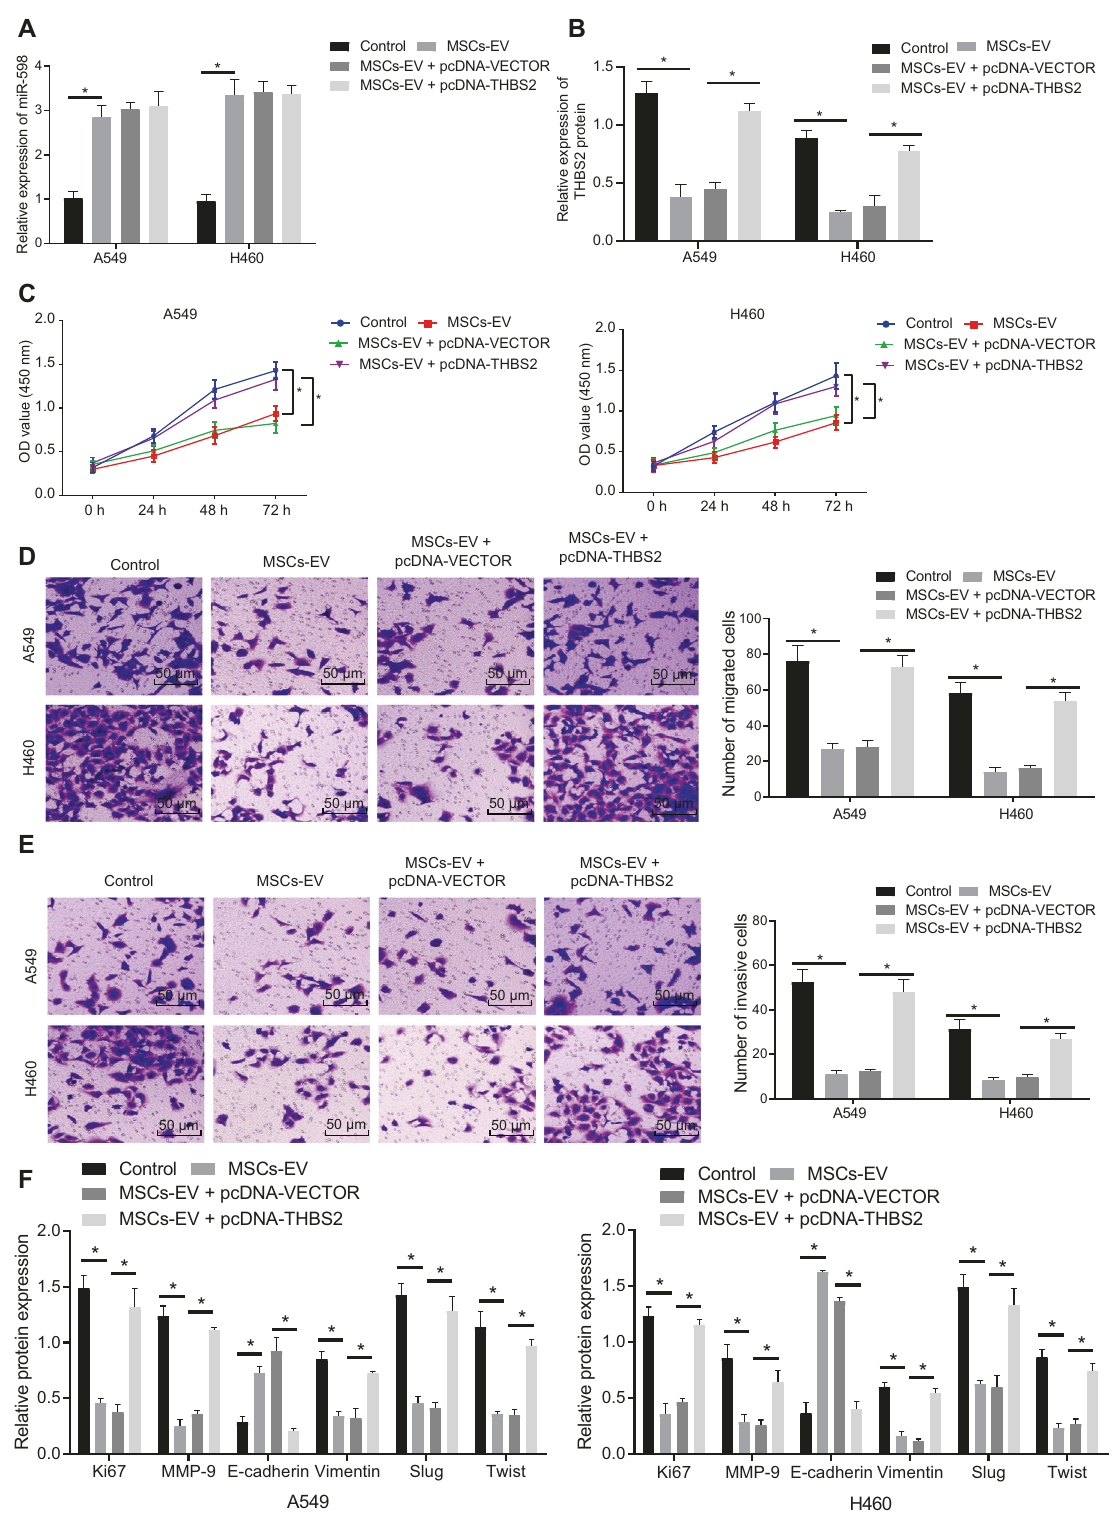
Fig. 7 Effects of EVs-derived miR-598 on the proliferation, migration, and invasion abilities of NSCLC cells via targeting of THBS2. A Expression of miR-598 in A549 and H460 cells treated with MSCs-EVs and pcDNA-THBS2 by RT-qPCR. B THBS2 protein level in A549 and H460 cells treated with MSCs-EVs and pcDNA-THBS2 by Western blot analysis. C Proliferative ability of A549 and H460 cells treated with MSCs- EVs and pcDNA-THBS2 detected by CCK-8 assay. D Migrated ability of A549 and H460 cells treated with MSCs-EVs and pcDNA-THBS2 detected by Transwell assay. E Invasive ability of A549 and H460 cells treated with MSCs-EVs and pcDNA-THBS2 detected by Transwell assay. F Protein levels of Ki67, E-cadherin, Vimentin, MMP-9, Slug, and Twist by Western blot analysis. * p < 0.05 between two groups. Comparisons among groups at different time points were performed using repeated measures ANOVA with Bonferroni ’ s post hoc test. Cell experiments were repeated three